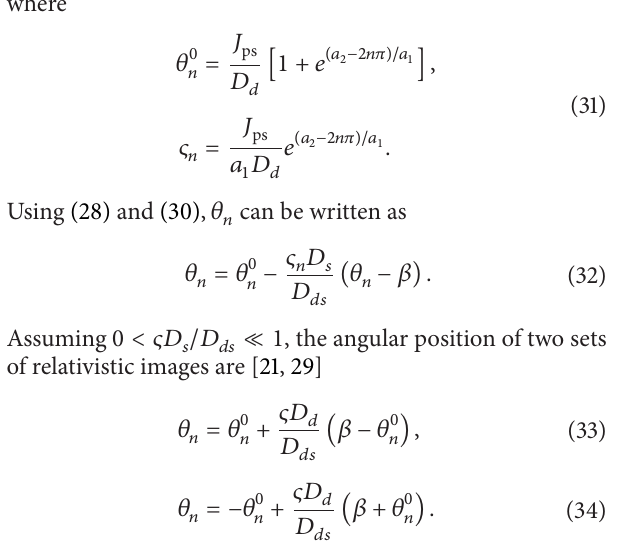
Figure 4: Basic lens formalism: position of source, image, lens, and observer are represented by 𝑆, 𝐼, 𝐿 , and 𝑂 . The distance between lens-source, lens-observer, and source-observer are denoted by 𝐷 𝑑𝑠 , 𝐷 𝑂 and 𝐿 is called 𝐷 𝑑 , and 𝑠 , respectively. The line connecting optical axis of the lens geometry. The angle 𝛽 is the location of the source 𝑆 , while the position of image is denoted by angle 𝜃 with respect to optical axis. The impact parameter is given by 𝐽 [36].